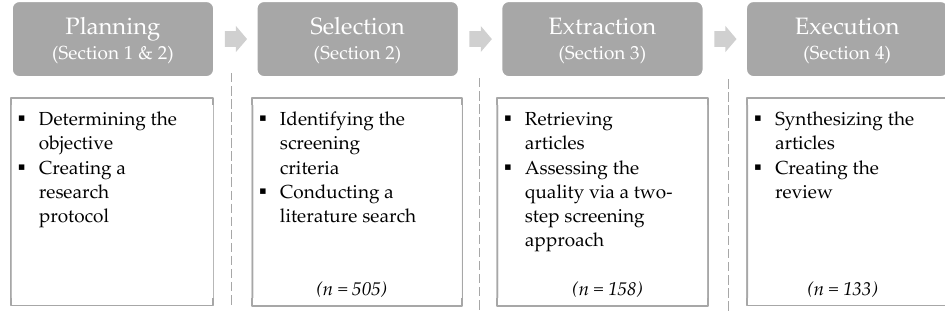
Figure 1. The research approach adapted from Okoli [8].